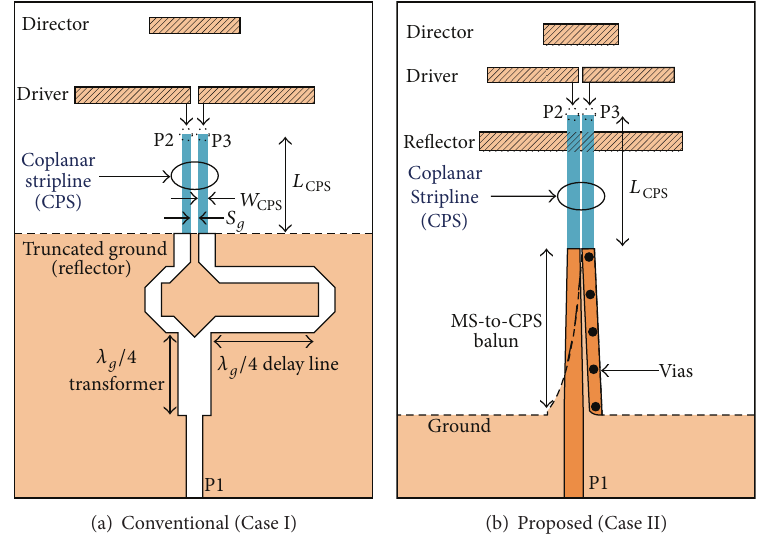
Figure 1: Two types of quasi-Yagi antennas using MS-to-CPS baluns.